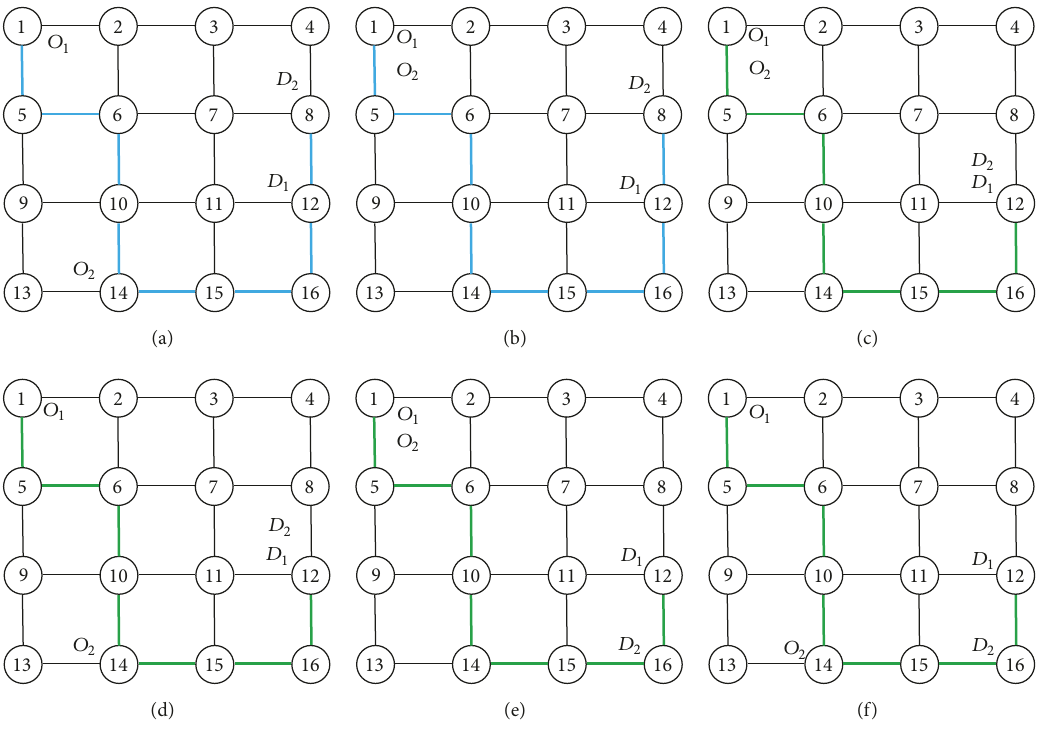
Figure 5: Sharing types in